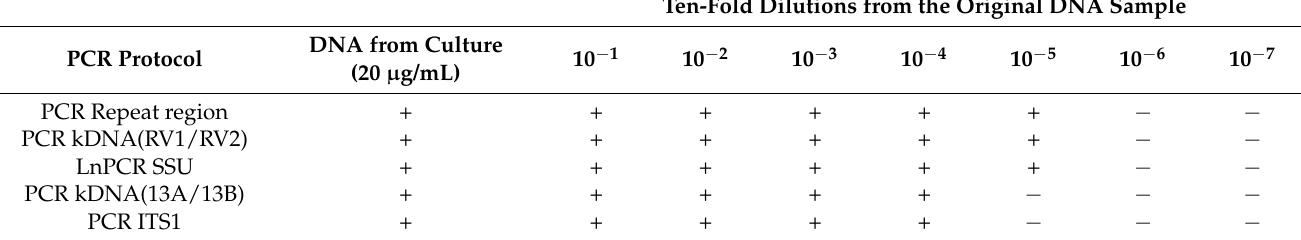
Ten-Fold Dilutions from the Original DNA Sample